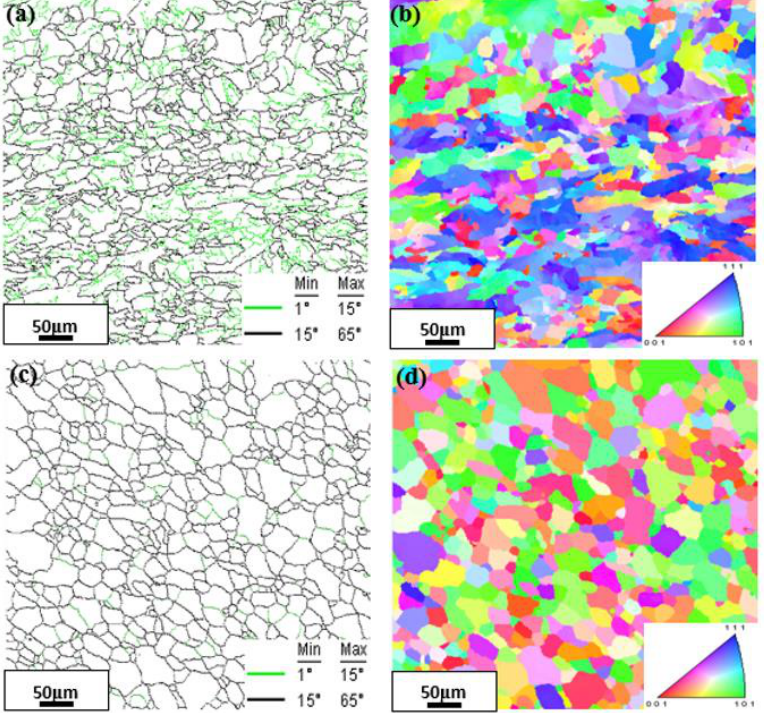
Figure 3. ( a ) the EBSD-characterized grain boundaries and ( b ) the IPF map of the initial forged con- dition; ( c ) the EBSD-characterized grain boundaries and ( d ) the IPF map of the representative an- nealed condition of